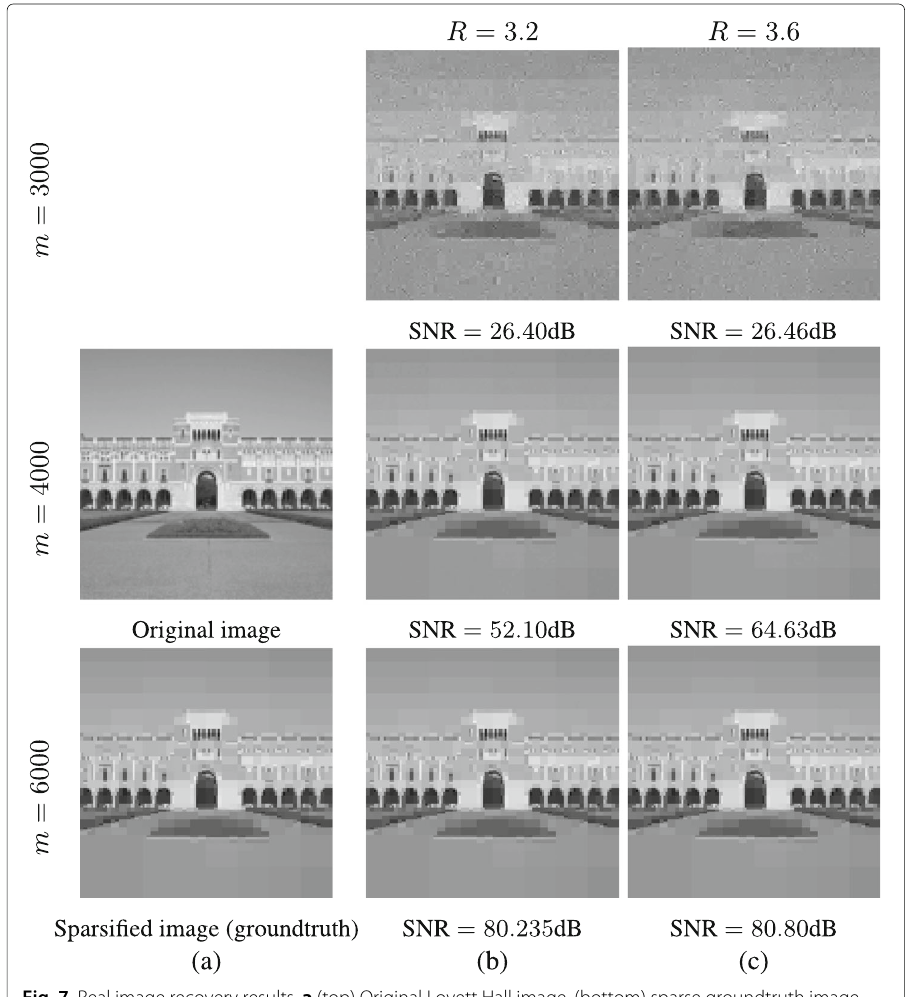
Fig. 7 Real image recovery results. a (top) Original Lovett Hall image, (bottom) sparse groundtruth image with s = 800; sparse reconstructions using m = 3000 (top), m = 4000 (middle), and m = 6000 (bottom) measurements for b R = 3.2 and c R = 3.6. The SNR values are with respect to the sparse groundtruth